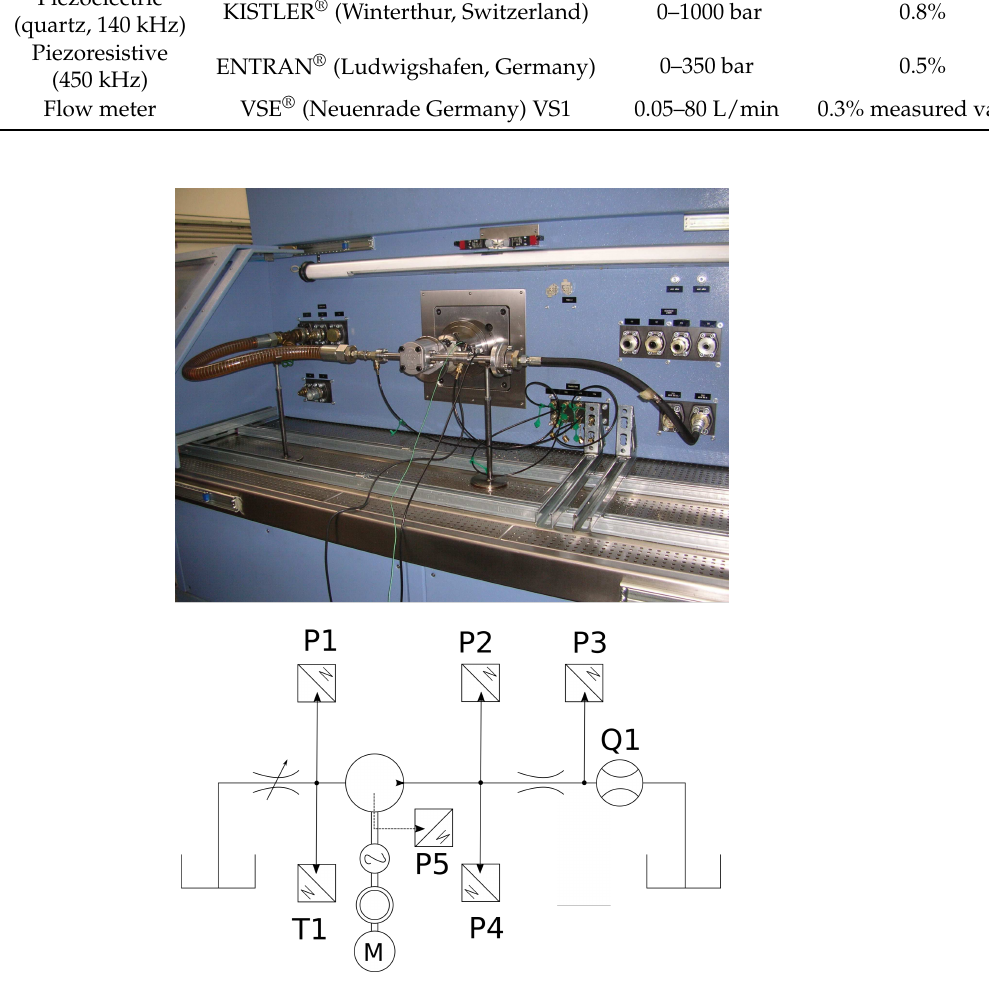
Figure 15. Experimental setup and its ISO